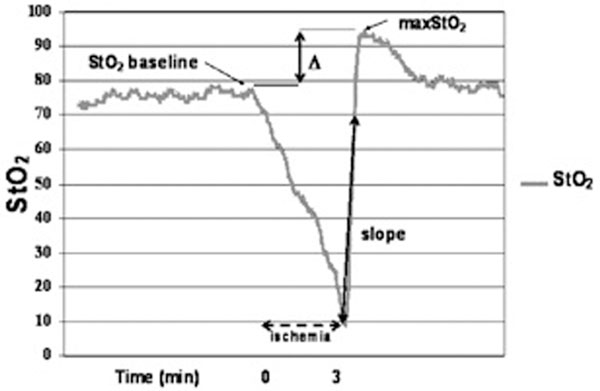
Dynamic changes of StO2 during ischemic challenge.